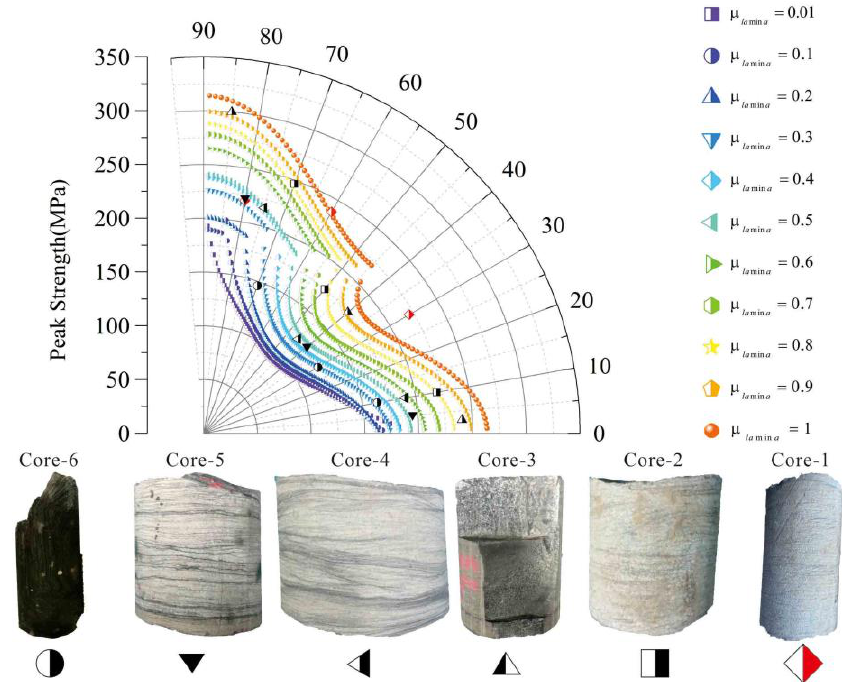
Figure 5. Function curves calculated with the modified T–K criterion using different lamina coefficients ( μ lamina ). Black points in different shapes indicate the different laminated rocks. Notably, peak strength values of Core-1 (with inconspicuous lamina) in the red points do not agree with the calculated function curves.